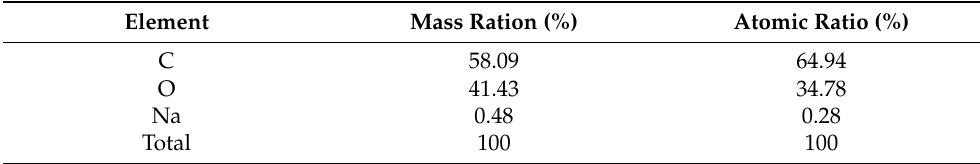
Table 2. EDS element distribution of liquid mulch film. Element Mass Ration